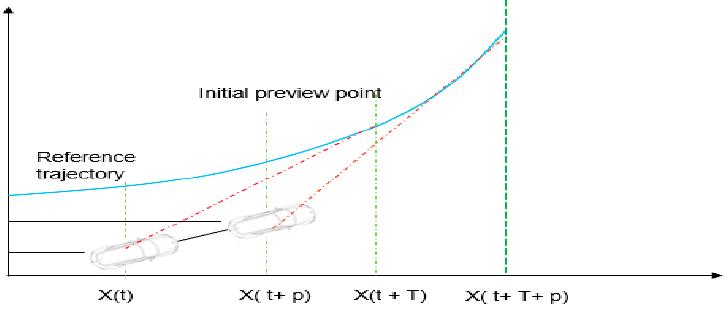
Figure 2. Prediction horizon combing MPC and PC.